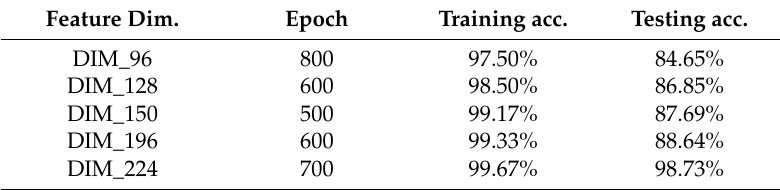
Table 6. Accuracy of different dimension (dim.) reductions of long short-term memory (LSTM). Feature